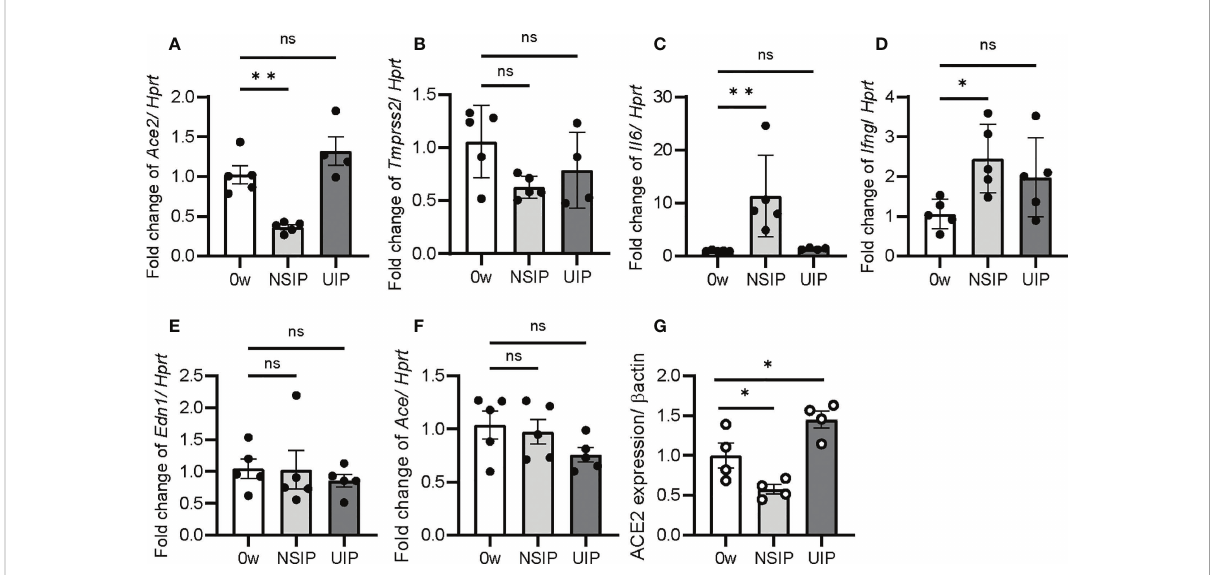
FIGURE 2 Ace2 expression was increased at UIP stage. The expression of Ace2, Tmprss2 , Il6 , Ifng , Edn1 , and Ace was determined by qPCR in the whole lung extract (A – F) and western blotting for ACE2 expression (G) . Data are presented at week 0 as the controls and at the NSIP, and the UIP stages. Hprt and b -actin were used as the internal controls for qPCR and western blotting, respectively. Data are presented as mean ± SE of four to fi ve mice at each stage. Asterisks indicate * P < 0.05, ** P < 0.01, compared with week 0. “ ns ” is not statistically signi fi